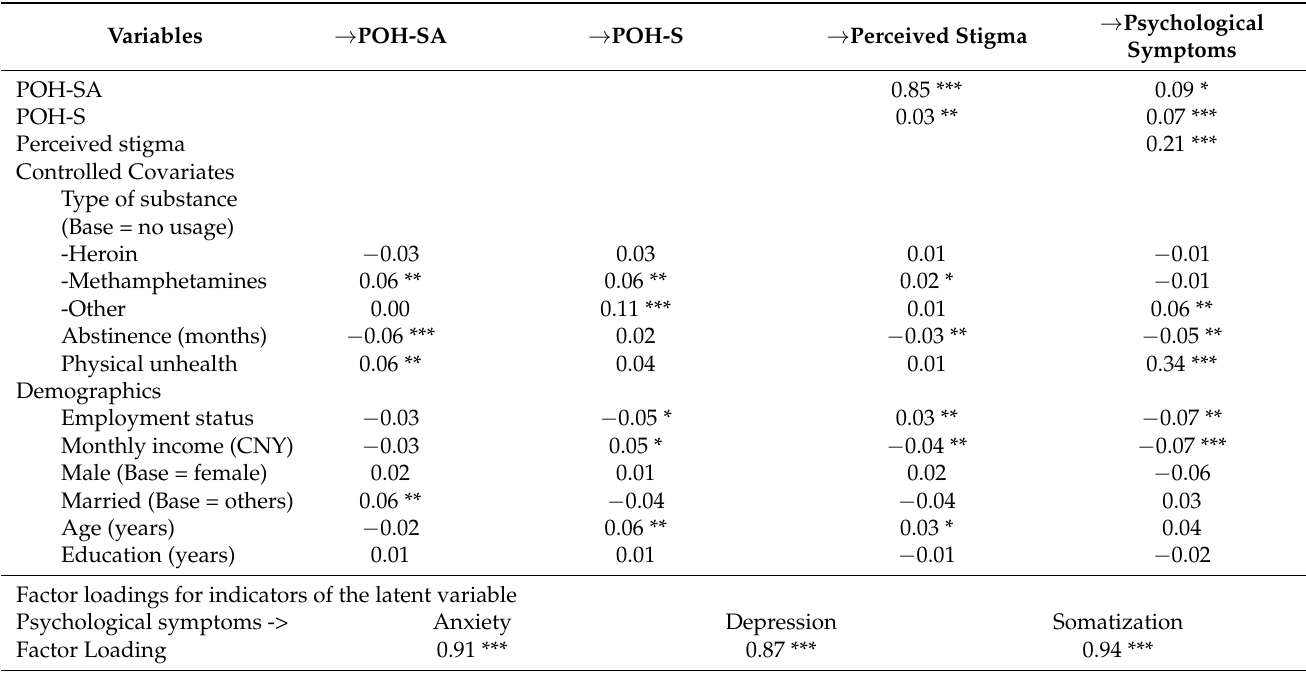
Table 3. Standardized SEM results ( n =